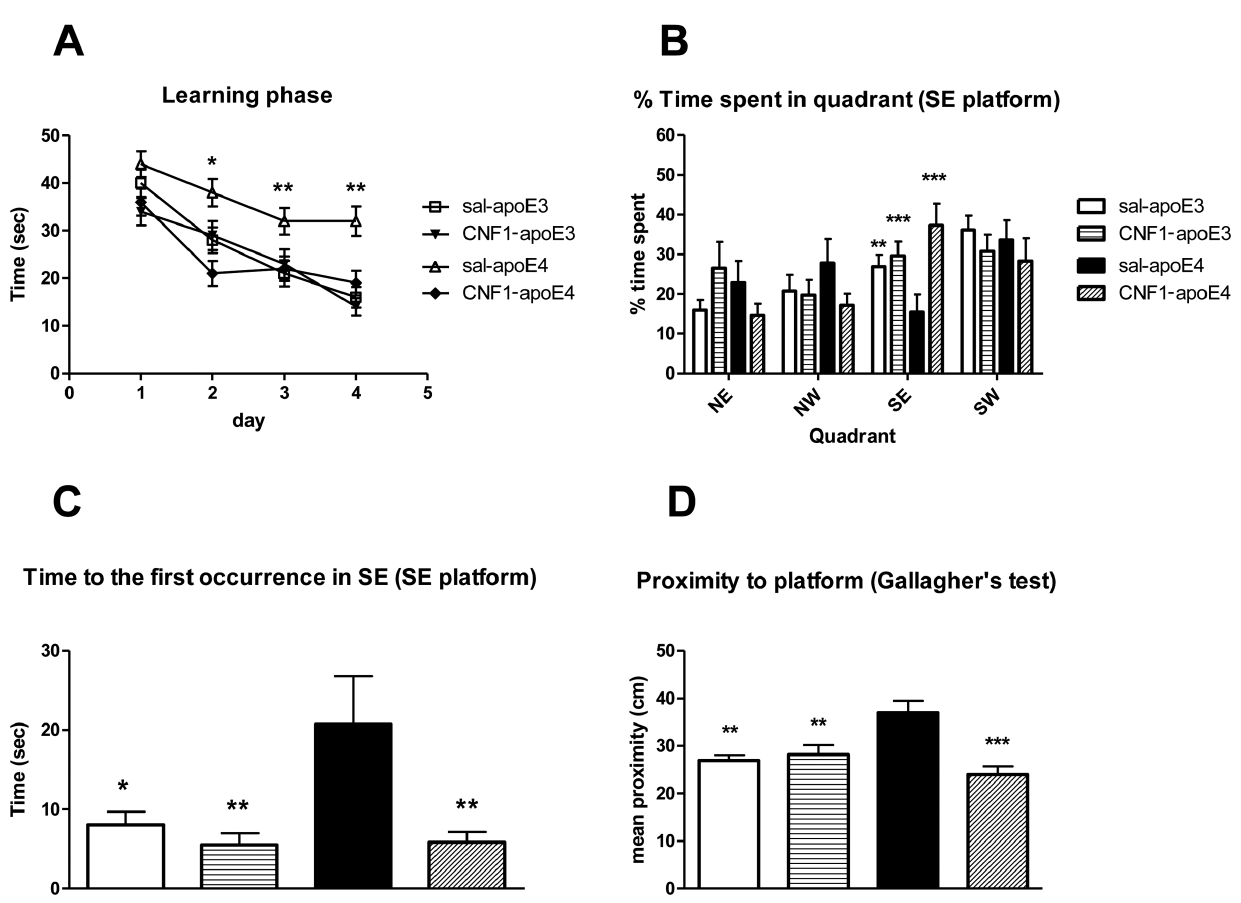
Figure 1. Effects of apoE genotype and CNF1 treatment in the Morris water maze test. Morris water maze performance in 12 month-old apoE3 and apoE4 (13–14 mice/group) with a intraventricular saline or CNF1 (0.1 nM) injection. A. Learning curve for training to find the hidden platform in the Morris water maze. The latency to find the platform in the 4 sessions of each day was averaged in order to obtain one value/animal/ day. Mean 6 standard error of the mean (SEM) values are shown. Statistical analysis of the overall learning curve was performed by means of repeated measures two-way ANOVA, for detailed statistical analysis, see Results. B, C and D. Probe test performance. Quadrants are designated as follows: SE = the quadrant of the maze that contained the submerged escape platform during training, NE = the quadrant of the maze to the left of the training quadrant, SW = the quadrant of the maze to the right of the training quadrant. NW = the quadrant of the maze directly opposite to the training quadrant. B. % Time spent in the quadrant where the platform was placed during the training phase. C. Latency to reach the platform position for the first time. D. Gallangher’s proximity test (mean proximity to former platform location). Data are shown as mean 6 SEM. For detailed statistical analysis, see Results. *=p , 0.05, **=p , 0.001 and ***=p , 0.0001 saline-apoE4 vs. all other groups.